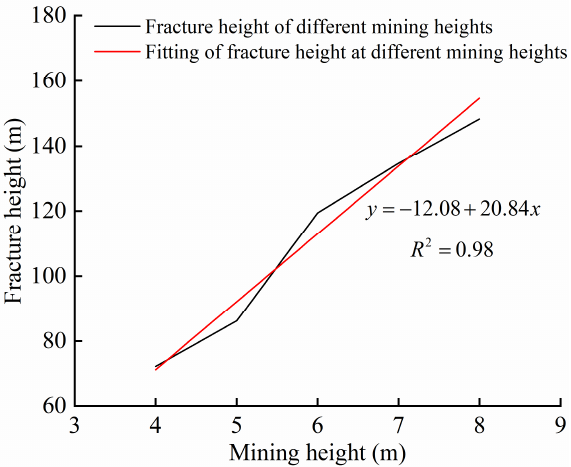
Figure 9. The fit curve of the development height of overlying strata fractures under different mining height